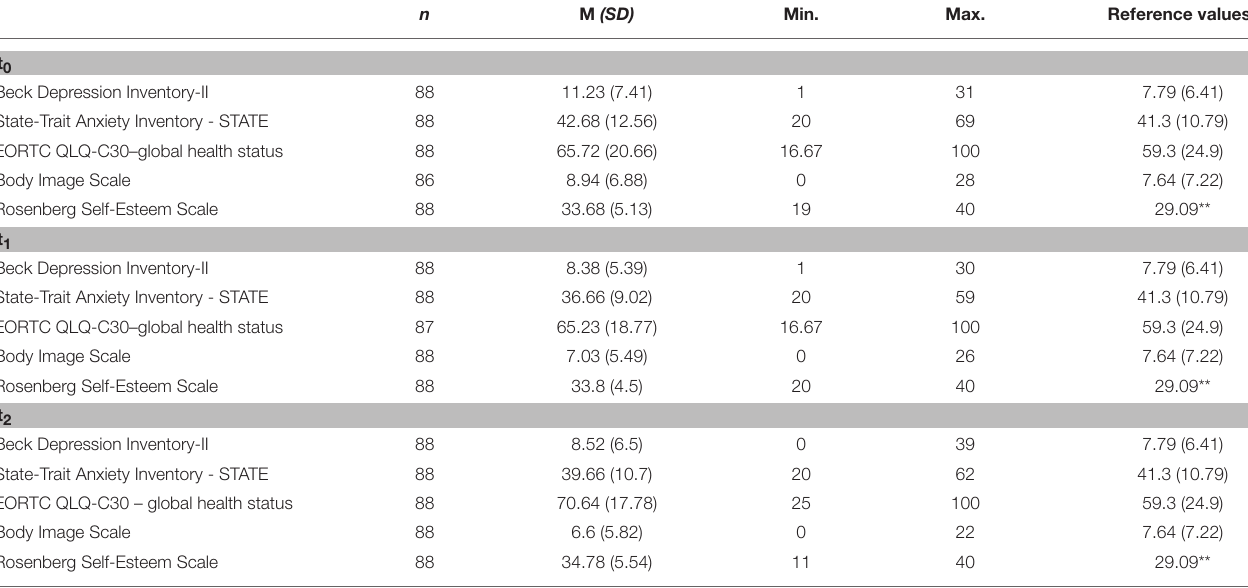
TABLE 2 | Descriptive statistics of investigated psychometric variables of interest at each time point. n M (SD) Min.